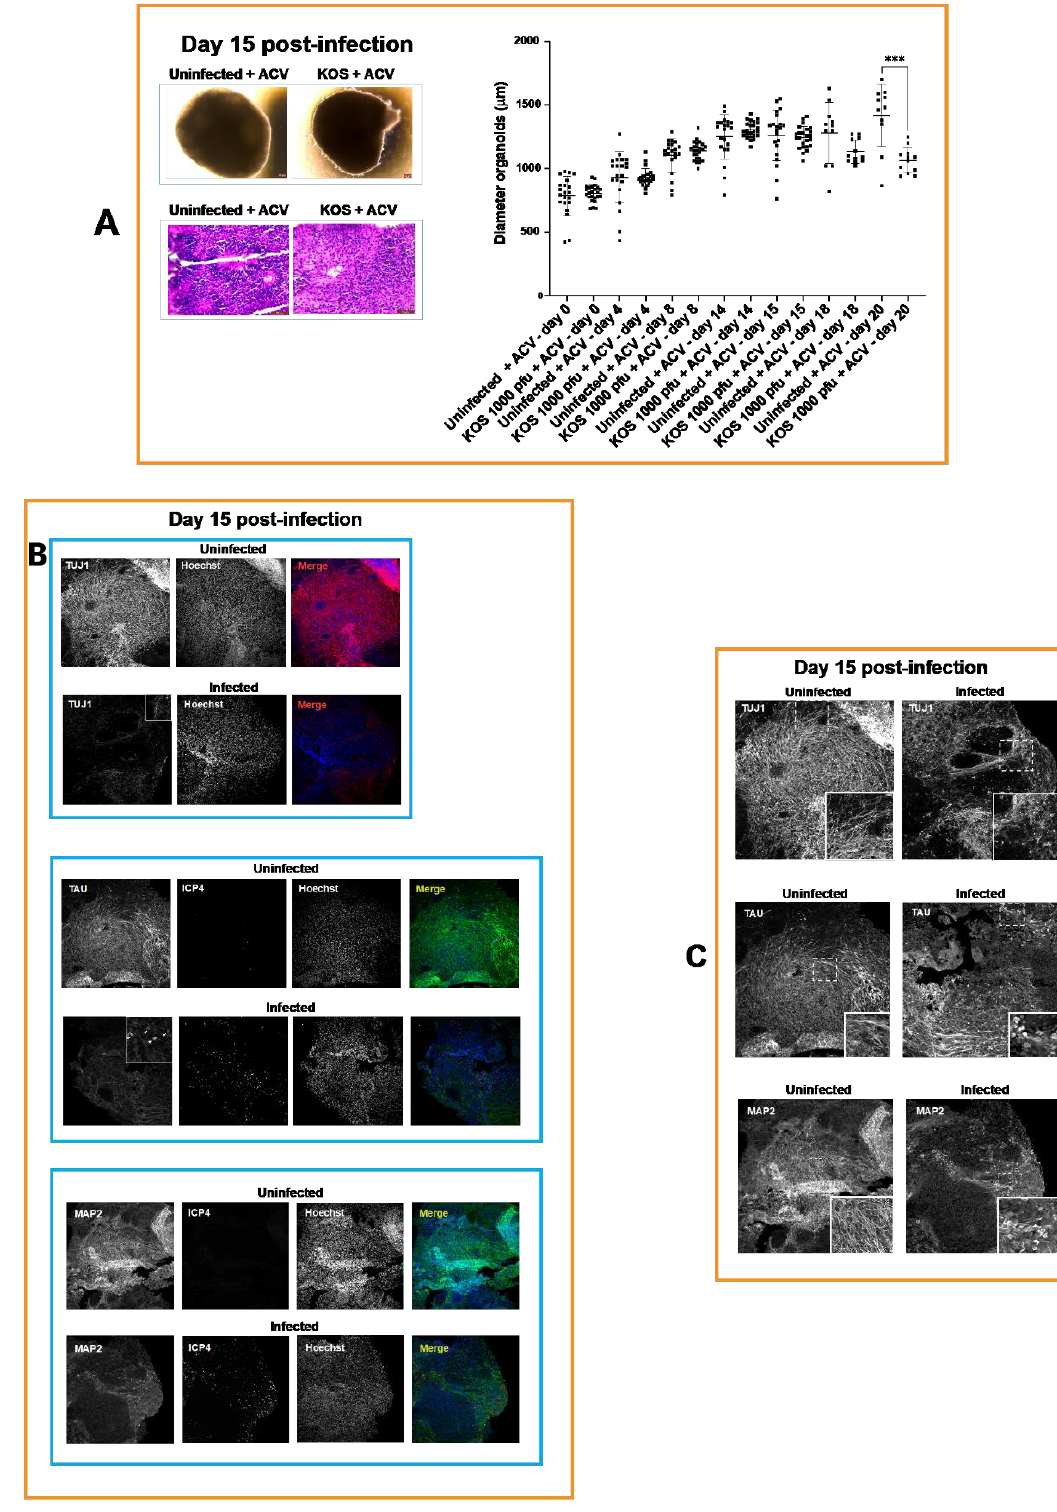
Figure 4. Analysis of infected organoids on day 15 p.i. ( A ) The infected organoids exposed to ACV began to show signs of loss of structural integrity and reduced size when compared to uninfected organoids exposed to ACV; however, this reduced size did not reach statistical significance.